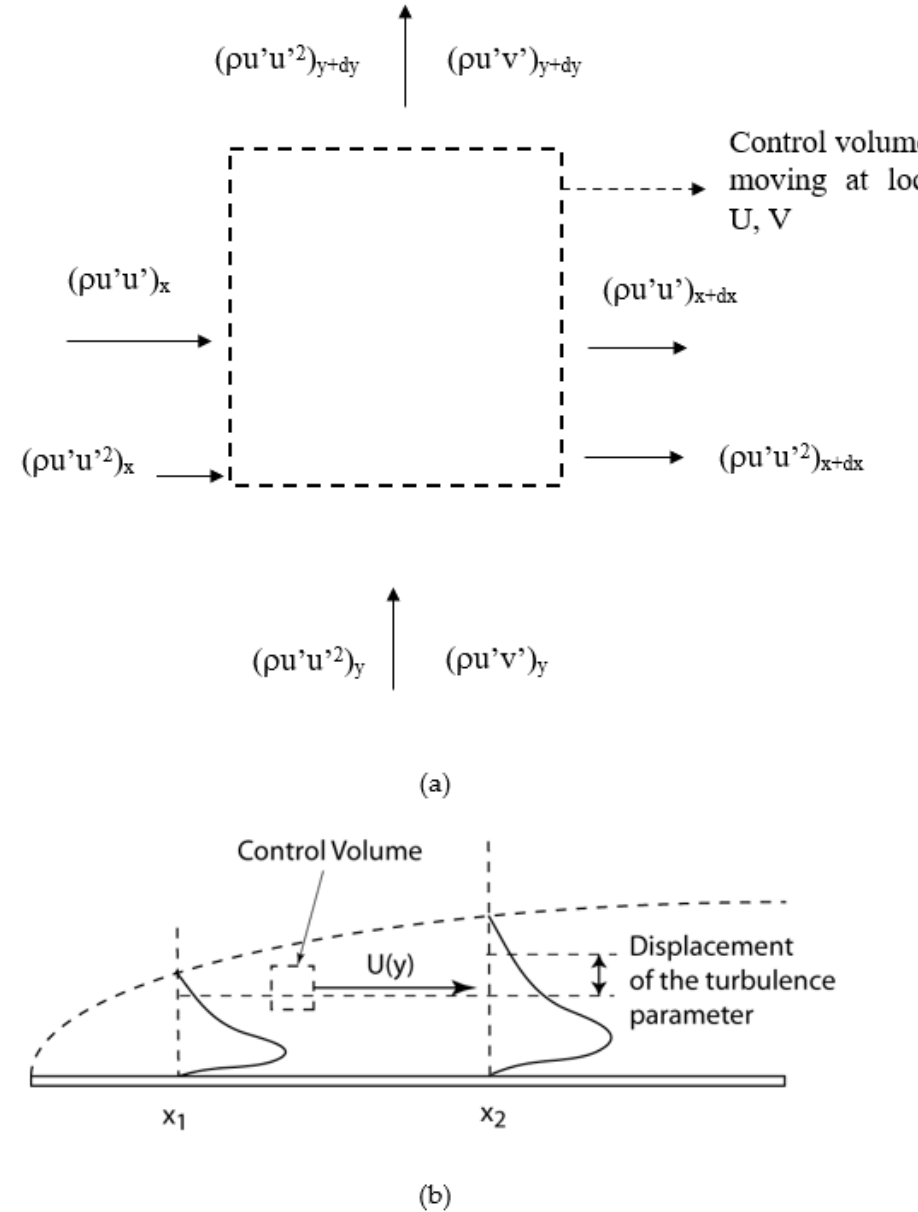
Figure A1. Schematics of the dynamics contained in the Lagrangian turbulence transport: ( a ) y-momentum (v’) and longitudinal kinetic energy balance (u’ 2 ) following a control volume, moving at the local mean velocity; and ( b ) the displacement concept leading to d/dx to d/dy transform.